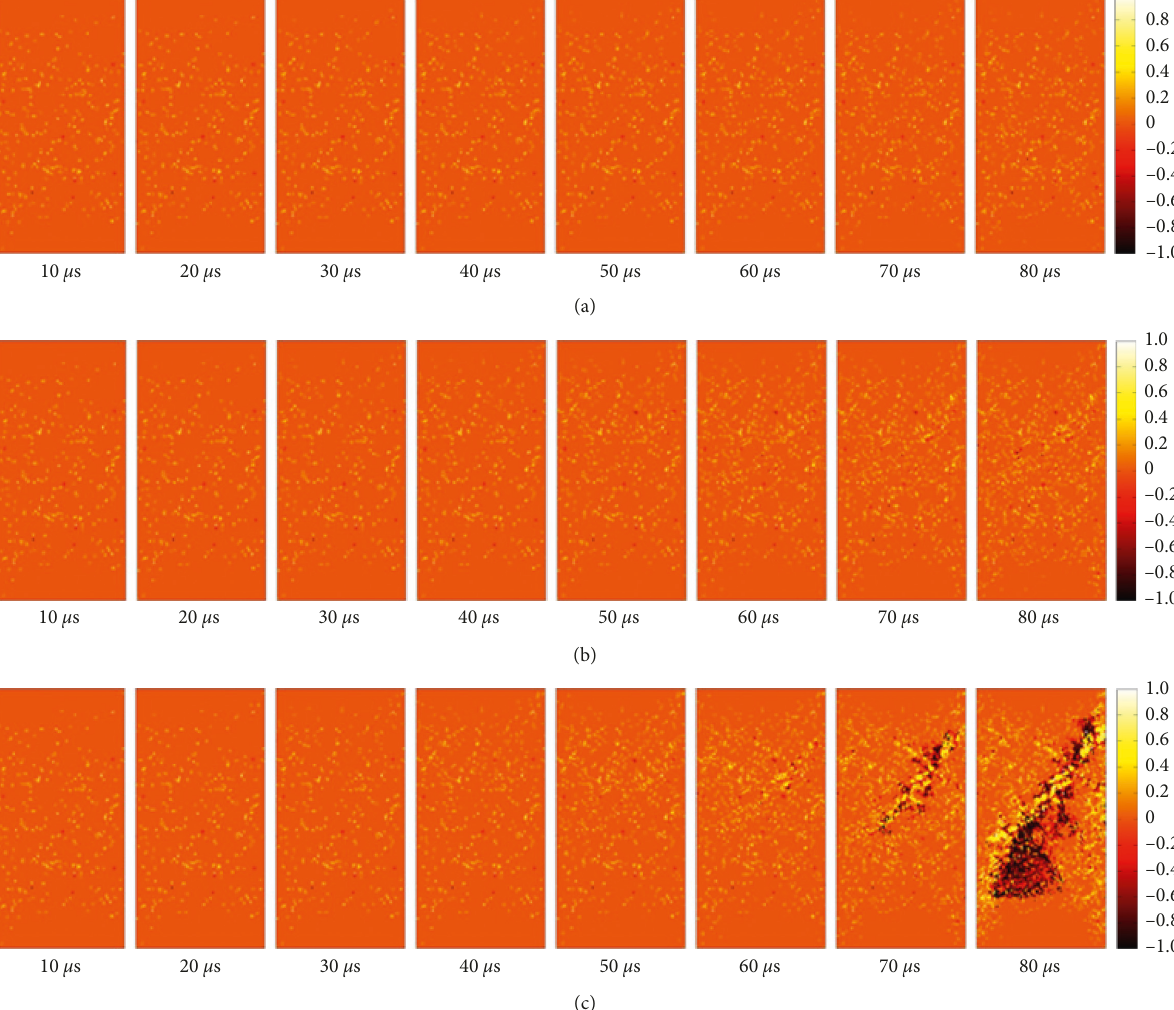
� 10MPa); (b) impact load dmax